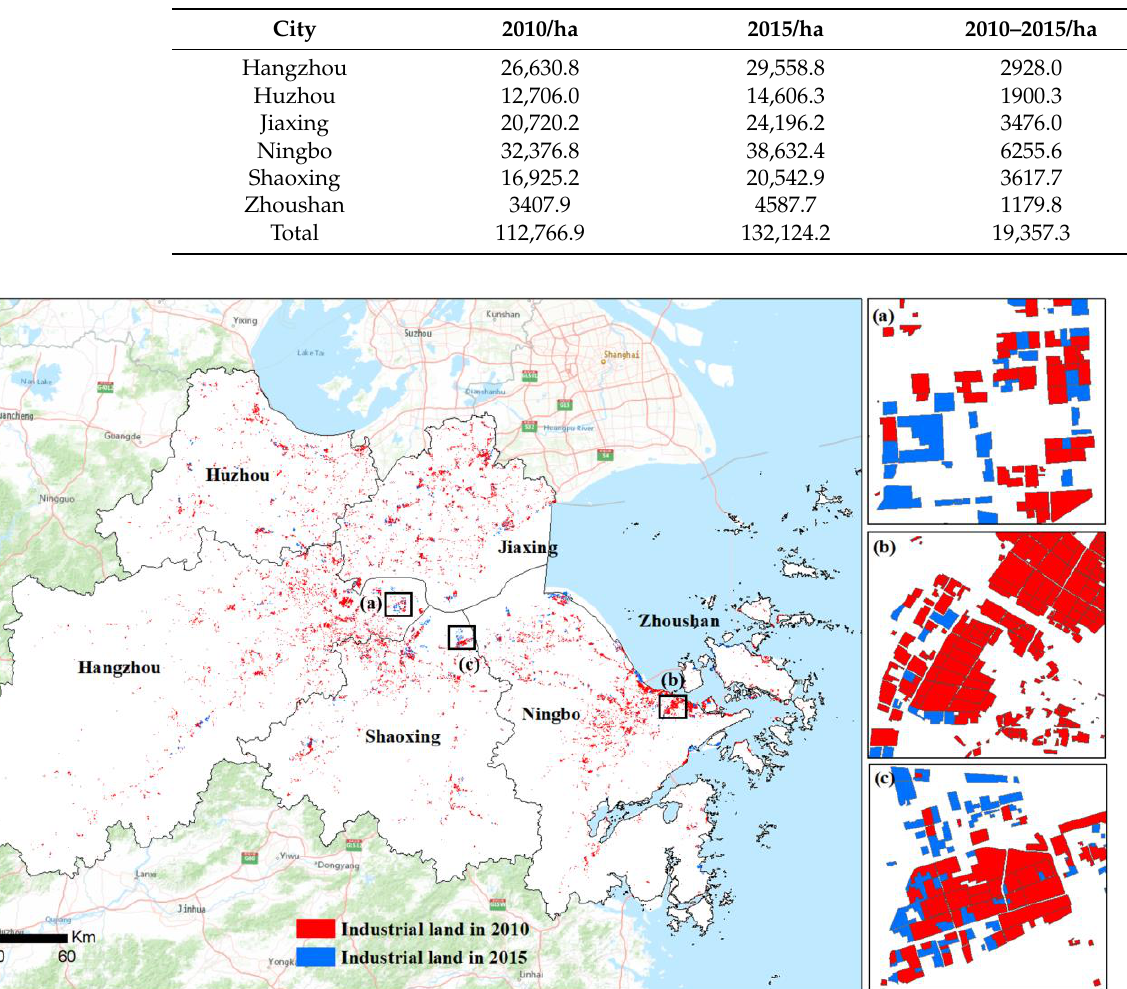
Table 3. Overall industrial dynamics of the UAHB by city.